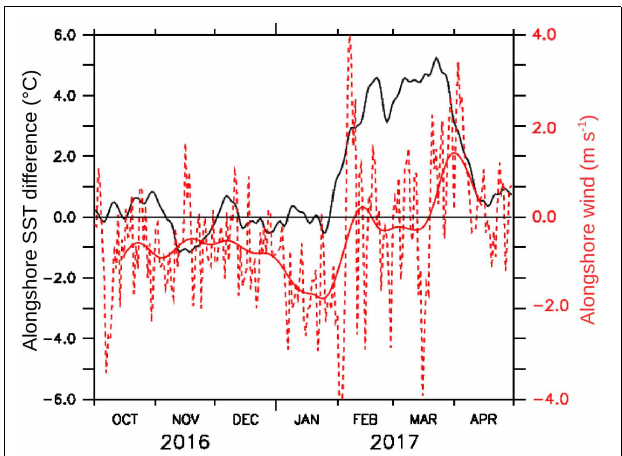
FIGURE 14 | Alongshore SST difference (in ◦ C, black line) and alongshore wind anomaly (in m s − 1 , red line). The SST difference was computed as the difference between the SST averaged in a northern coastal box (6–10 ◦ S, 0–100 km from the coast) and a southern coastal box (10–16 ◦ S, 0–100 km from the coast). The alongshore direction was the mean orientation of the coastline between 6 ◦ S and 14 ◦